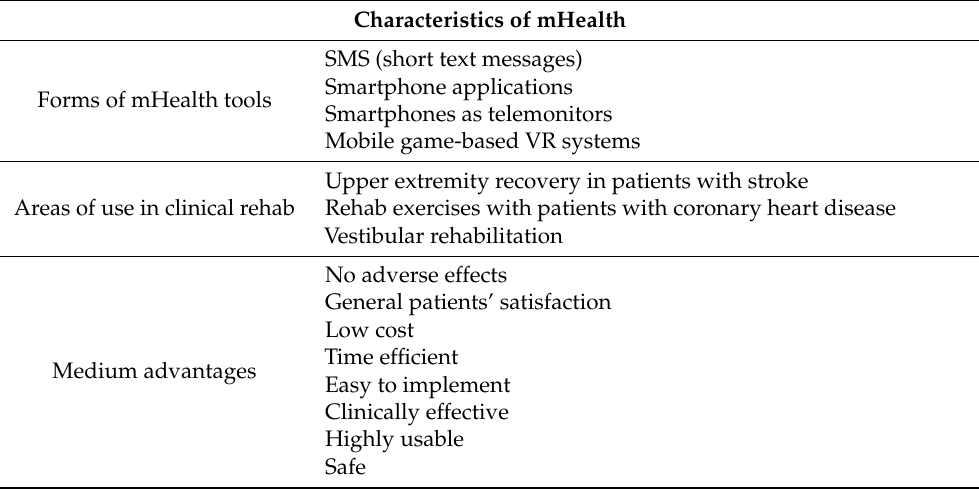
Table 2. Forms of mHealth, areas of use in clinical rehabilitation, and medium